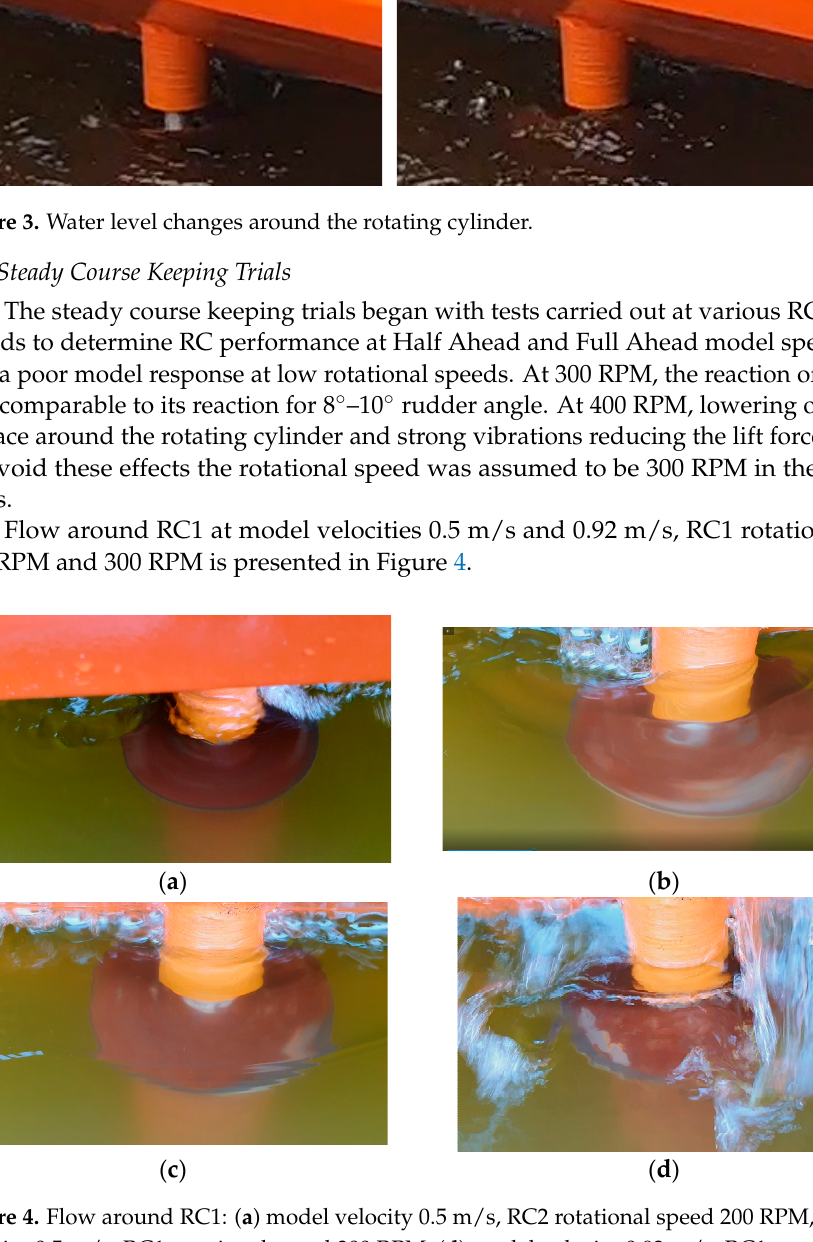
Figure 4. Flow around RC1: ( a ) model velocity 0.5 m/s, RC2 rotational speed 200 RPM, ( b , c ) model velocity 0.5 m/s, RC1 rotational speed 300 RPM, ( d ) model velocity 0.92 m/s, RC1 rotational speed 300 RPM.